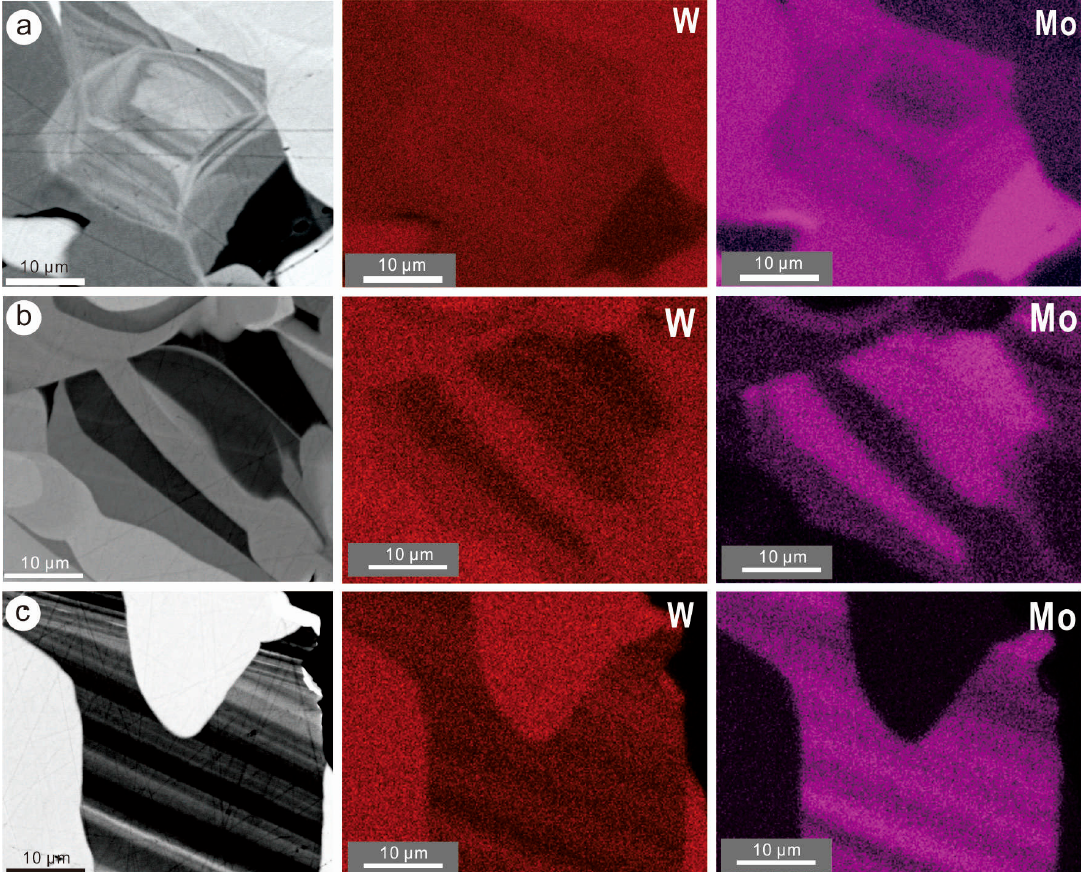
Figure 4. BSE images and scanning electron microscope (SEM)-energy-dispersive X-ray spectra (EDS) maps for three selected areas representing various styles of zoning in scheelite-powellite (Sch-Pow) aggregates. ( a ) Small crystal (~30 μ m diameter) of intermediate Sch-Pow composition (medium contrast on the BSE image) with sub-micron oscillatory zoning. ( b , c ) High-Mo slivers (strong contrast on BSE images) showing wider and finer oscillatory zoning with respect to Mo vs. W. Note the highest Pow (up to ~80 mol.%) was measured from such areas.